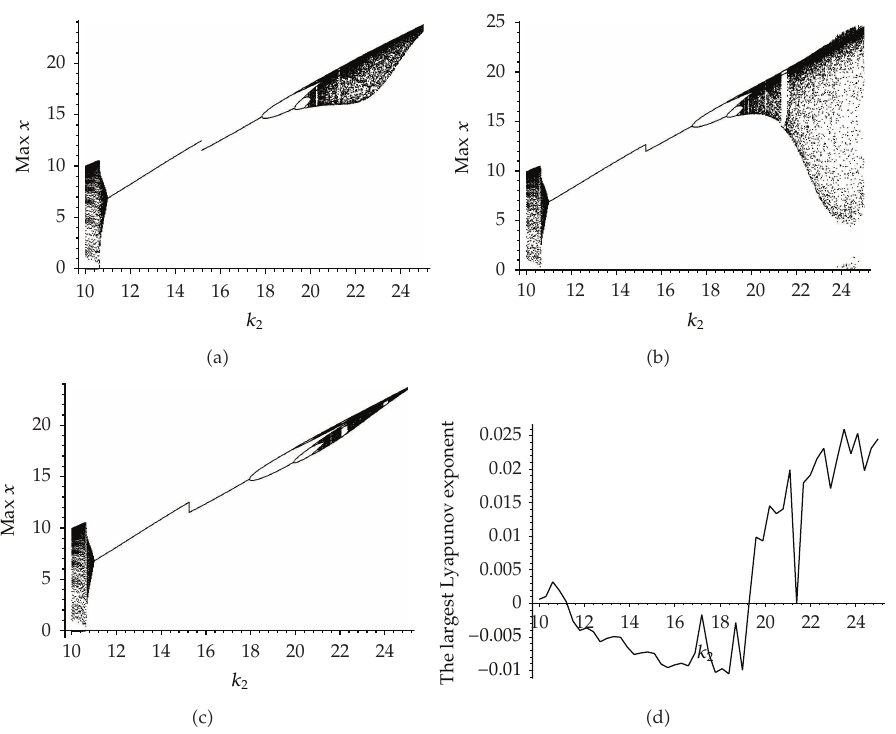
Figure 1: Bifurcation diagram of system (cid:7) 1.1 (cid:8) with initial conditions x 0 (cid:6) (cid:7) 0 . 1 , 0 . 1 , 0 . 1 (cid:8) . (cid:7) a (cid:8) ϕ (cid:6) 0; (cid:7) b (cid:8) ϕ (cid:6)